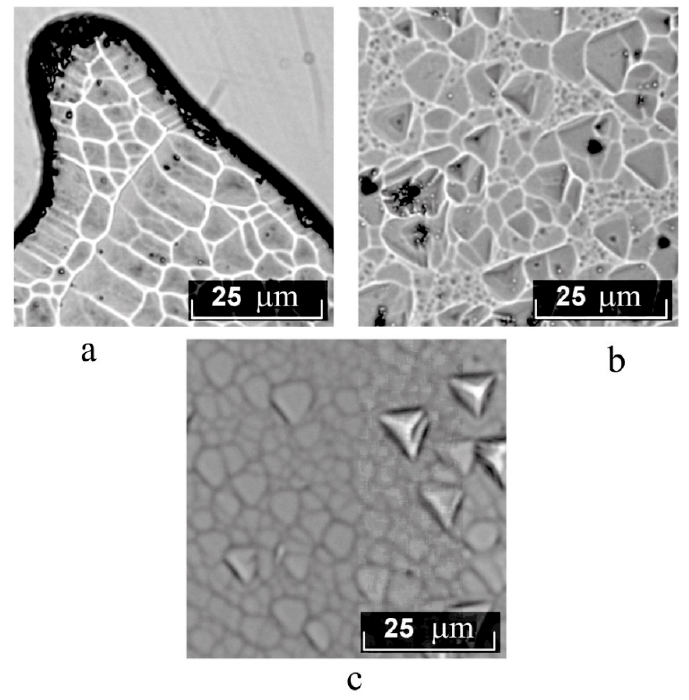
Figure A10. Mosaic structure: ( a )—with cells of different sizes, located near the macrodomain wall in the LiNbO 3 :Zn crystal ([ZnO] ≈ 4.77 mol% In the crystal); ( b )—In a LiNbO 3 : Mg crystal ([MgO] ≈ 4.7 mol% in a crystal); ( c )—with equiaxed cells in the LiNbO 3 :Ce crystal (direct doping, [Ce] = 0.5 mol% in the crystal), Z-cut.